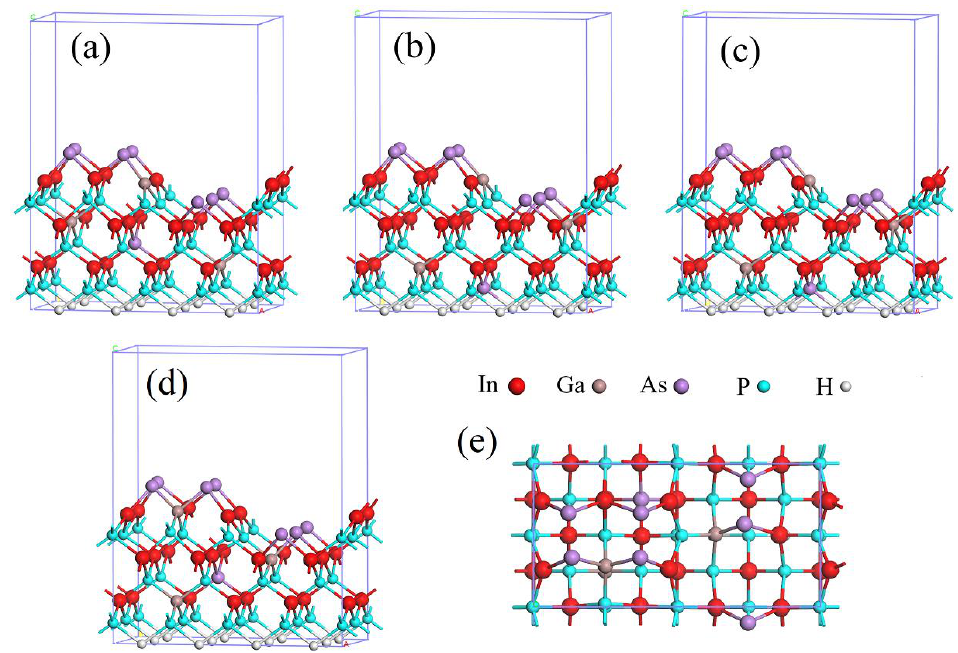
Figure 1. ( a – d ) Side views of different atomic configurations of In 0.87 Ga 0.13 As 0.25 P 0.75 (001)β 2 (2×4) surface model, ( e ) top view of ( d ).